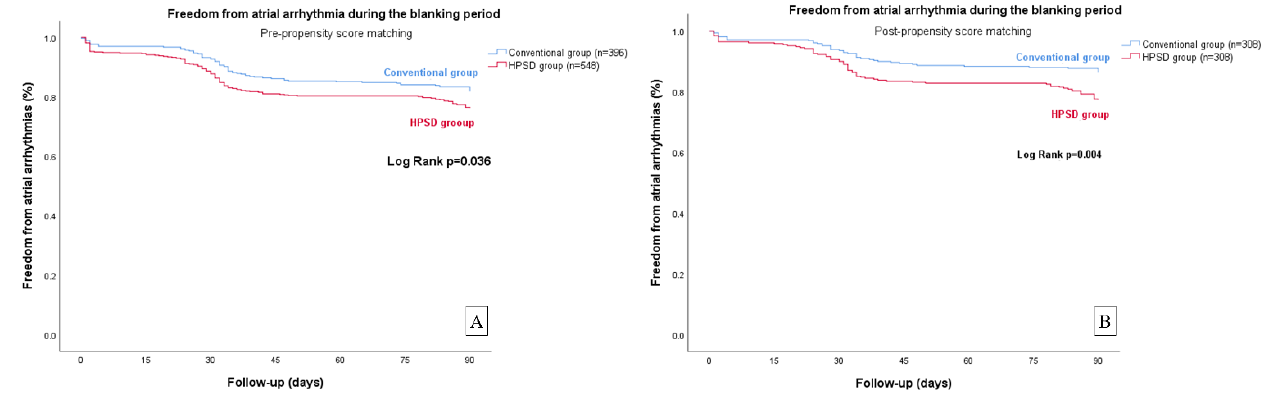
Figure 1. Kaplan–Meier survival analysis of freedom from arrhythmia during the blanking period. ( A ) Freedom from arrhythmia during the blanking period before propensity-score matching; ( B ) Freedom from arrhythmia during the blanking period after propensity-score matching.